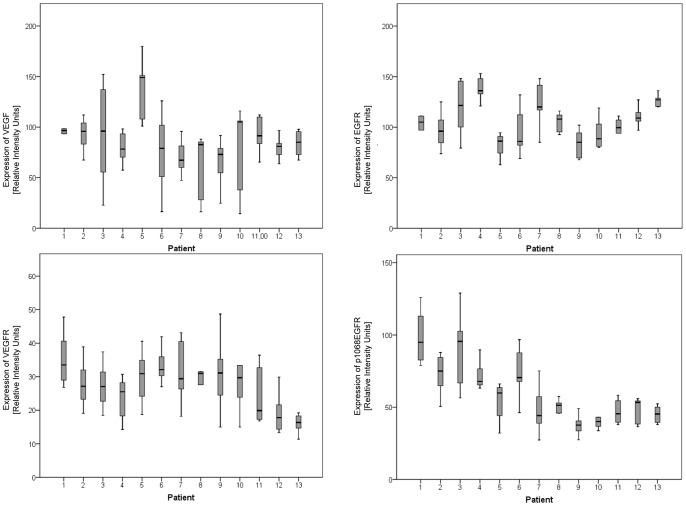
Intratumoral heterogeneity and variation among different patients for the expression of 4 exemplary proteins (VEGF, VEGFR, EGFR and p1068EGFR) assessed by reverse phase protein arrays.Box plots show the median (line within the box), 25th and 75th percentiles, and whiskers are showing 1.5 times the interquartile range.